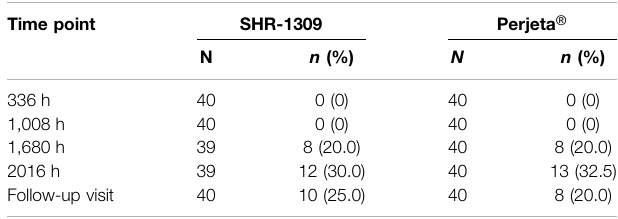
TABLE 4 | Summary of the incidence of